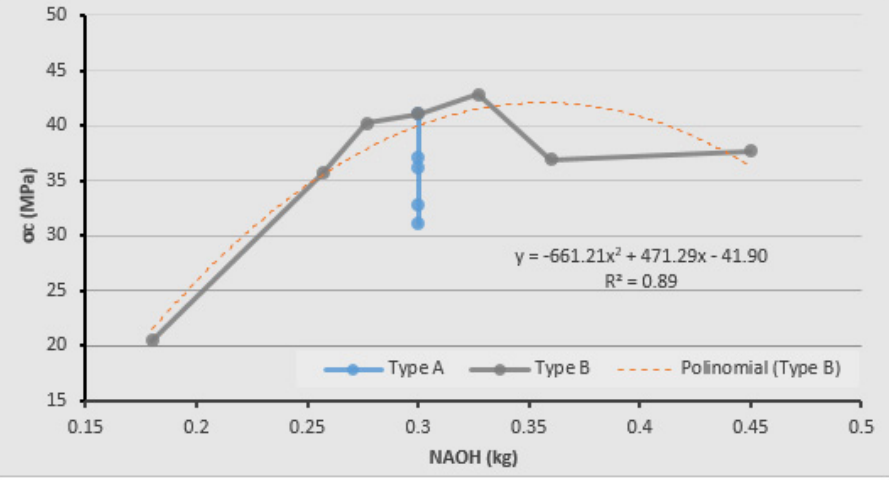
Figure 10. Influence of sodium silicate (Na 2 SiO 3 ) on the compressive strength. Finally, the results seem to show that combination 1:2 (Base Mix) is the most adequate to obtain a material with good properties for structure applications. However, the activator composition of 300 g of NaOH, 450 g of Na 2 SiO 3 and 150 g of water is more economic than the Base Mix and does not seem to lead to mechanical characteristics of inferior quality. 5. Conclusions The main objective of this work was to evaluate the variation of the mechanical properties, mainly the tensile and compressive strengths with the variation of the composition of geopolymers. Different activator compositions were tried in order to conclude about the consequences in terms of mechanical properties and the possibility of using these materials in structural members and ultimately in the construction industry. The values obtained for the tensile and compressive strength of geopolymers are good in comparison with those of OPC mortar. Some changes in the composition proved not to affect the mechanical properties significantly. This is a good indication because it shows that there is room for some adaptation of the composition when some practical problems need to be solved. One of the